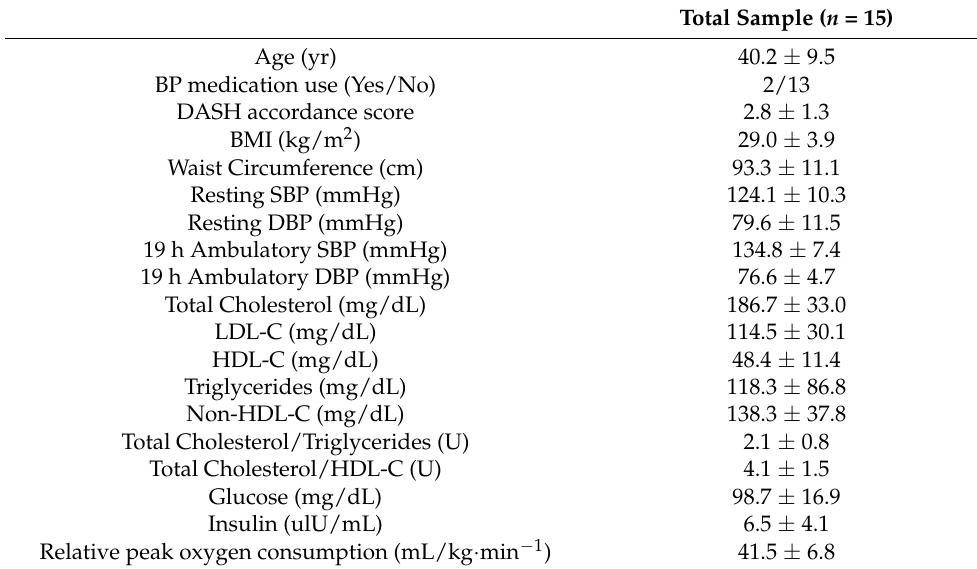
Table 1. Subject Characteristics (Mean ±